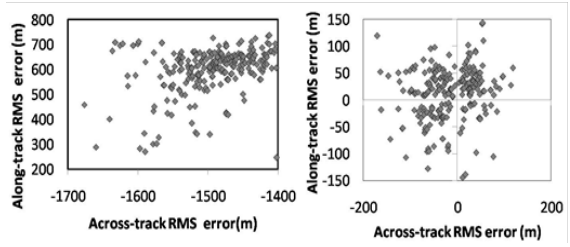
Figure 6 Absolute location performance of L3 after correction